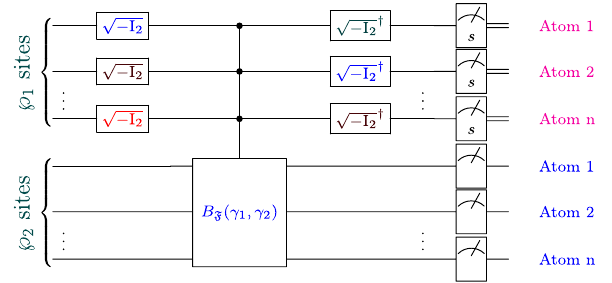
Figure 6. The proposed scheme to solve the Simon problem in the presence of dissipation, where B F (γ 1 , γ 2 ) indicates the dissipative quantum circuits or black-boxes (oracles). For more details on the design of various types of B F (γ 1 , γ 2 ) , see Supplementary